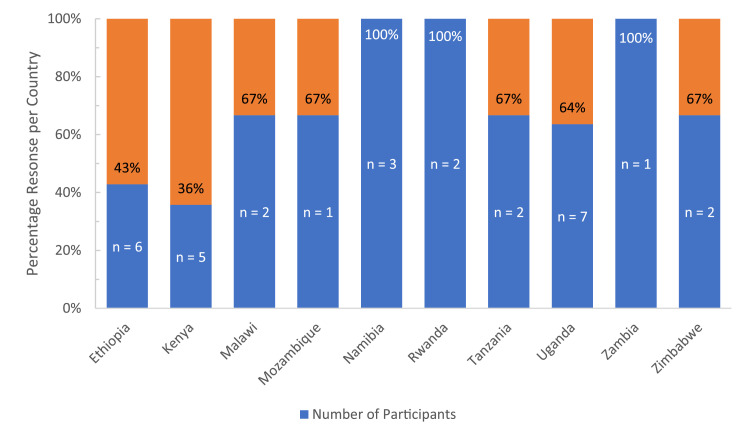
Participants by Country.